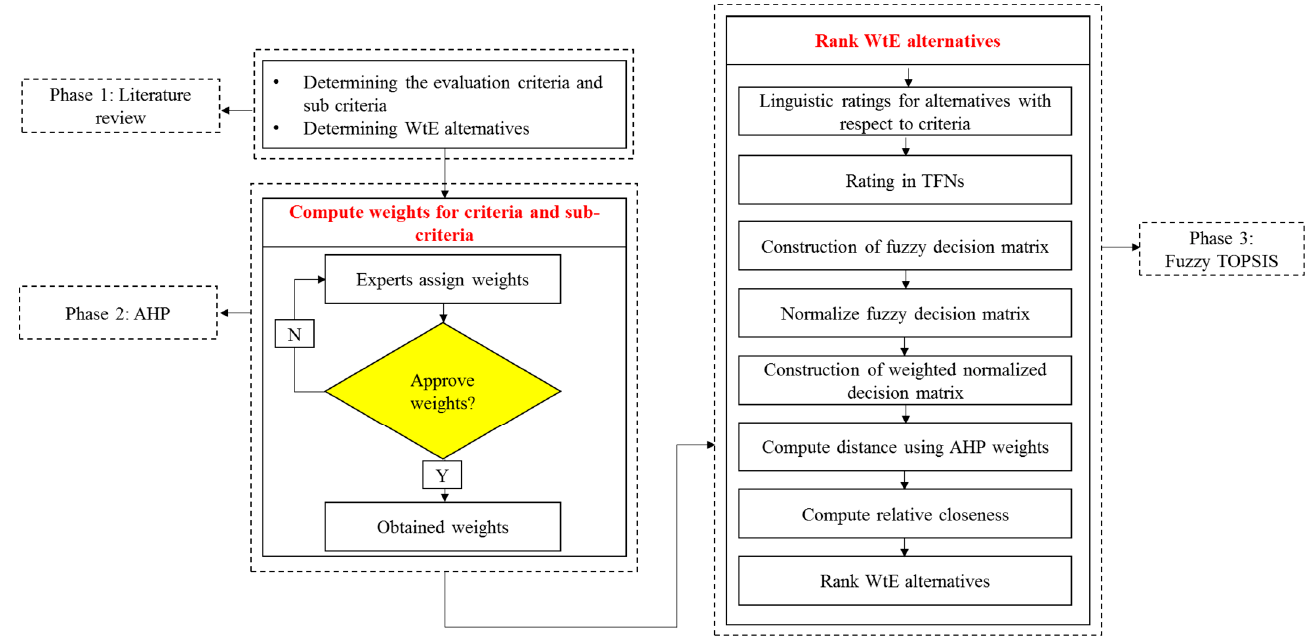
Figure 3. The process of selecting the optimal WtE alternative depicted in a methodological frame- work.